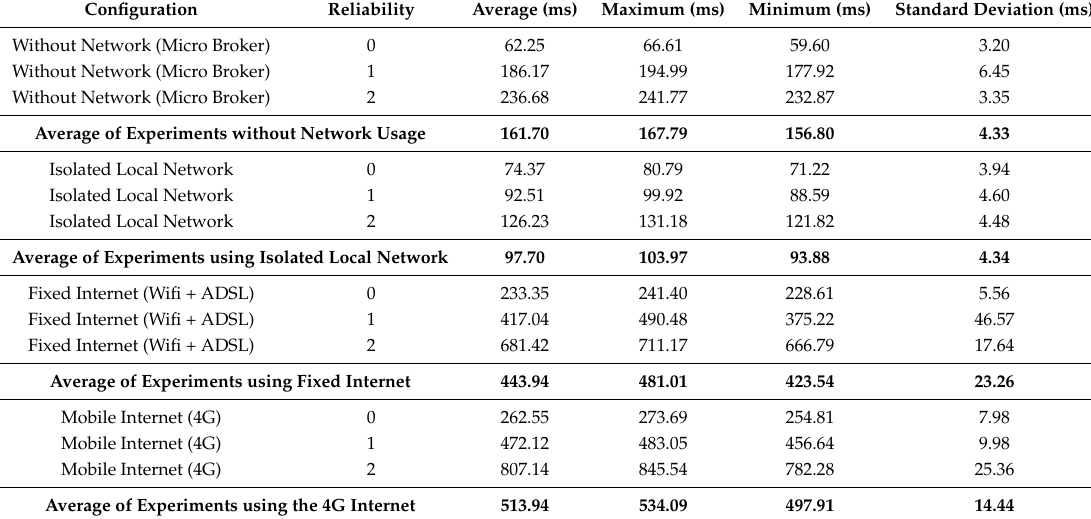
Table 2. Evaluation of the Distribution Service Performance in relation to the Communication